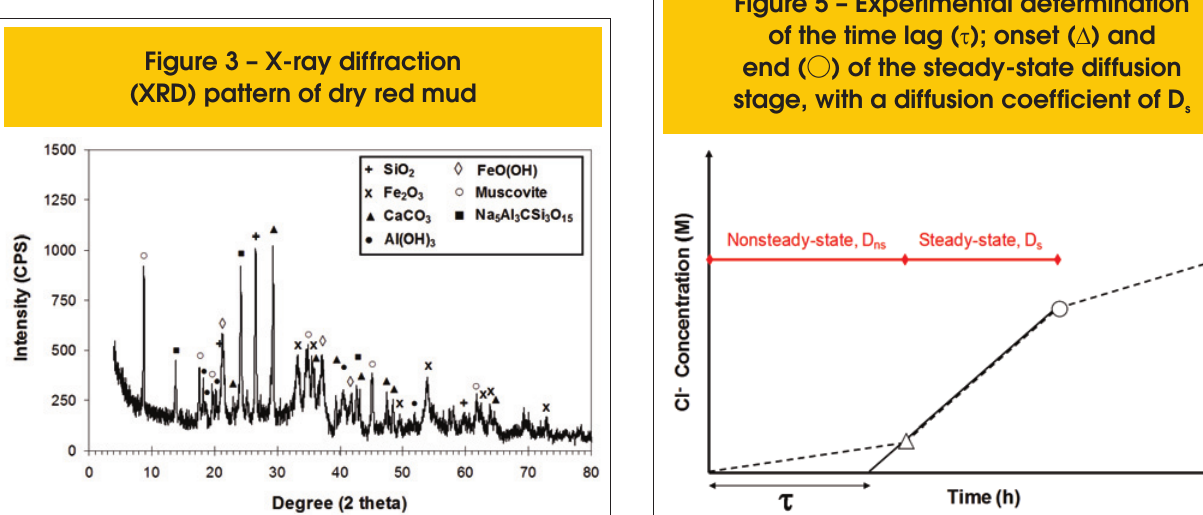
Figure 3 – X-ray diffraction (XRD) pattern of dry red mud